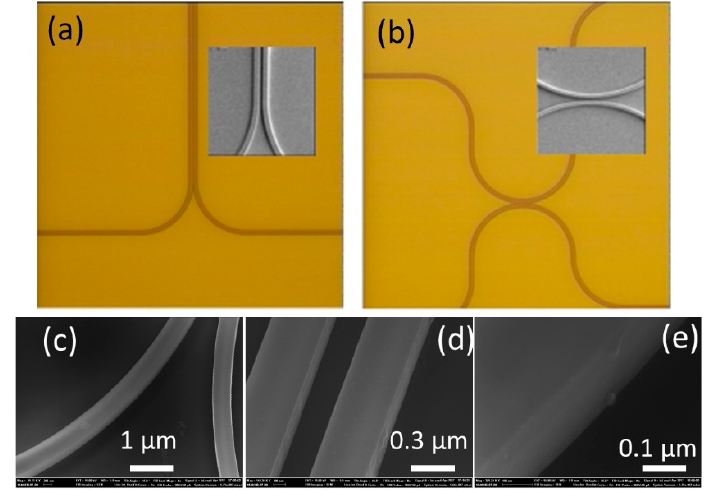
Figure 10. ( a , b ) Typical optical and SEM micrographs of our directional couplers. ( c – e ) Low sidewall roughness has been achieved in both straight waveguides ( d ) and bends ( c , e ).